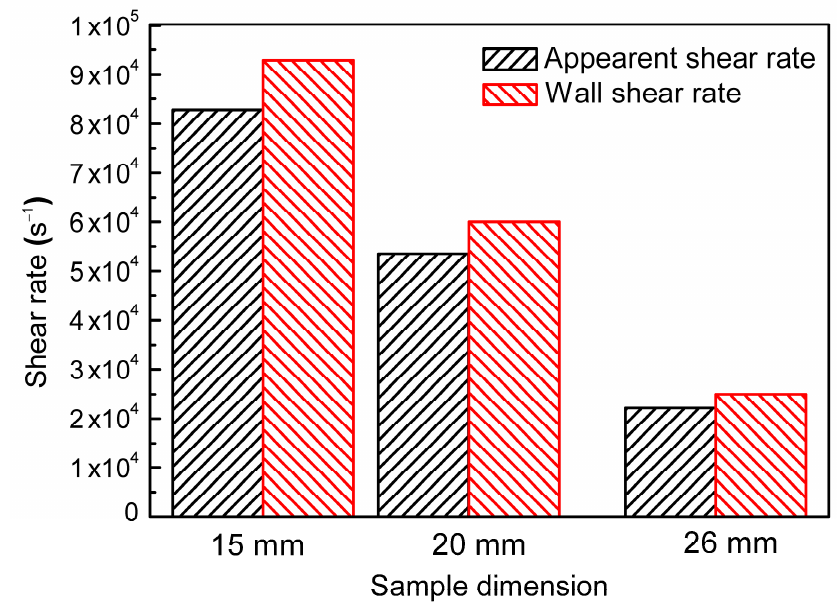
Figure 2. The shear rate in the mold cavity of micropart with different sample